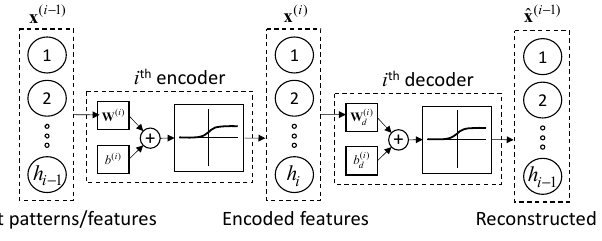
Figure 1. An autoencoder aims at reconstructing its input at its output.